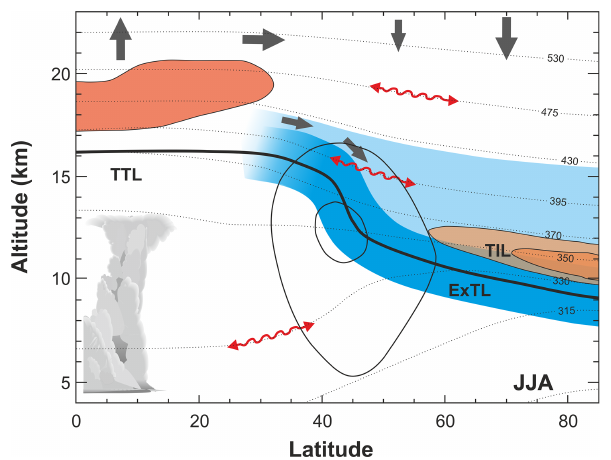
Figure 9. Illustration of dynamical and chemical structure of the UTLS for Northern Hemisphere summer (JJA) conditions (adapted from Fig. 2b of Gettelman et al., 2011). The thick black line rep- resents the thermal tropopause for the period 2002 to 2008. Dotted lines are isentropes. Black solid contours indicate the location of the subtropical jet (STJ). Areas of enhanced static stability (tropopause inversion layer) are indicated by red shading. The extratropical tran- sition layer (ExTL) is represented in dark blue and the lowermost stratosphere (LMS) above the ExTL in light